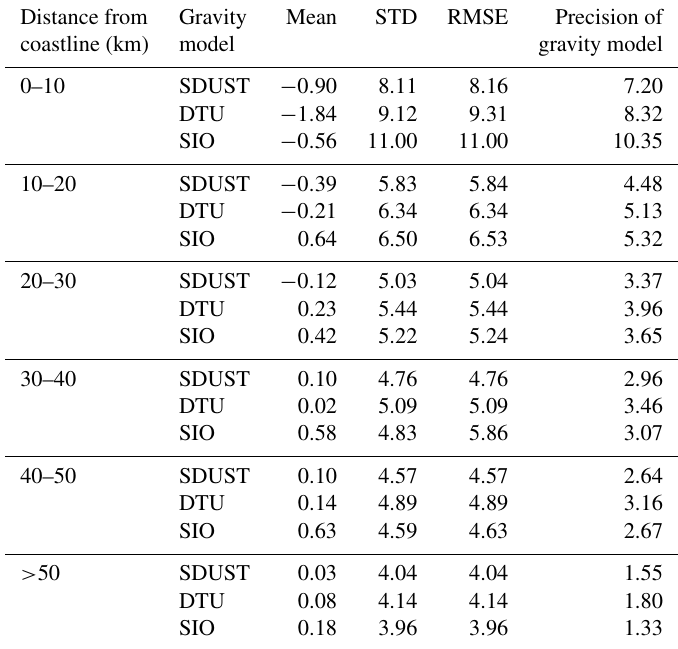
Table 5. Statistics of differences between altimetric and shipborne gravity in differences distances from coastline (unit: mGal). Distance